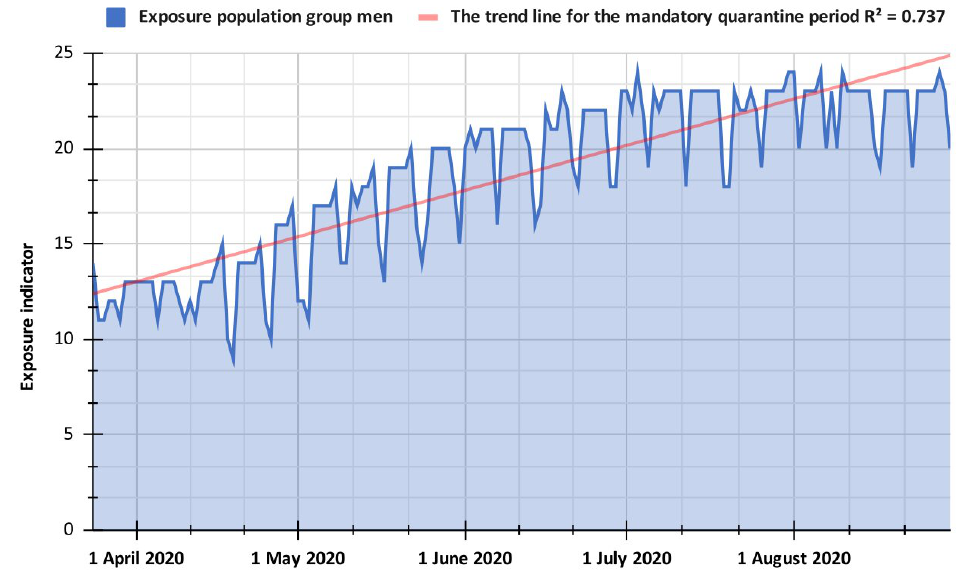
Figure 4. Exposure indicator for the mandatory quarantine period in the Popayán